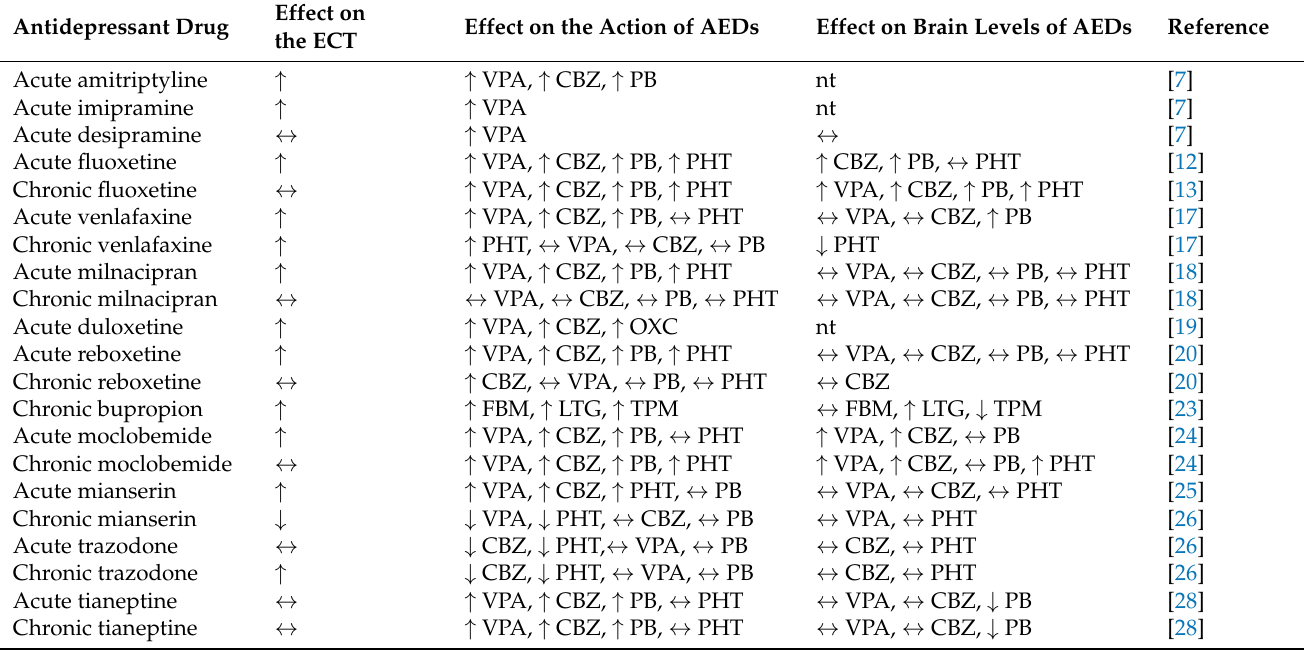
Table 1. Effects of antidepressant drugs on the electroconvulsive threshold and the antielectroshock action of antiepileptic drugs. Effect on Effect on the Action of AEDs Effect on Brain Levels of AEDs Reference Antidepressant Drug the ECT